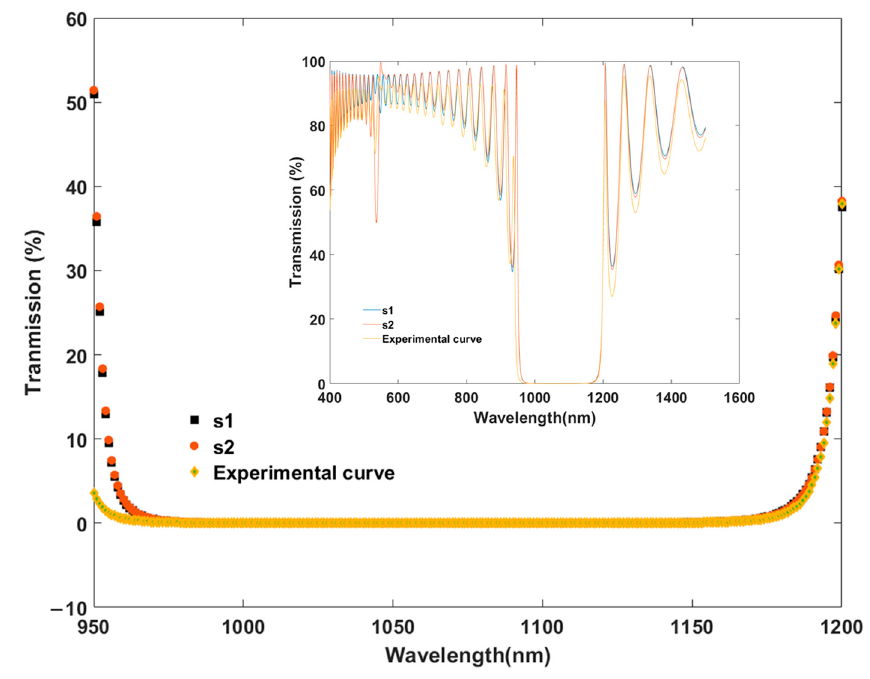
Figure 12. The transmission spectra for various structures in the range of 950~1200